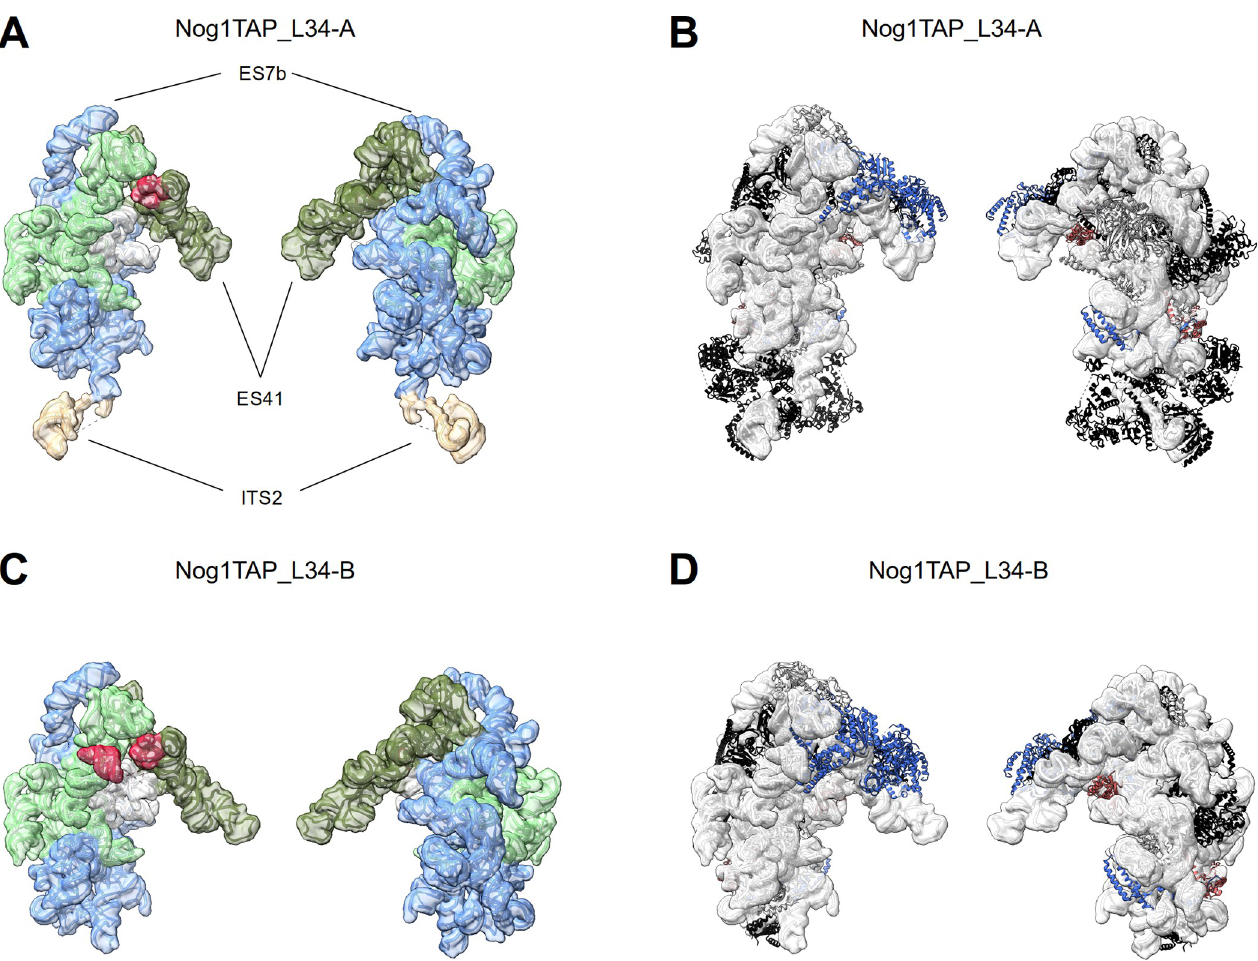
Fig 4. rRNA folding states and structure models of Nog1-TAP associated particle populations from yeast cells in vivo depleted of rpL34 (Y2907). Folding states of rRNA domains and a structure overview are shown for Nog1TAP_L34-A in (A) and (B) and for Nog1TAP_L34-B in (C) and (D). Structure model visualisation and protein colouring for (B) and (D) is described in the legend of Fig 2 and rRNA domain visualisation and colouring for (A) and (C) in the legend of Fig 3. In (A)—(D) the LSU subunit interface side is shown on the left and the subunit solvent surface side on the right. The individual LSU rRNA helices as well as the protein composition and model-based interaction networks detected in structure models Nog1TAP_L34-A and Nog1TAP_L34-B are schematically represented in figures M and N in S1 Appendix.